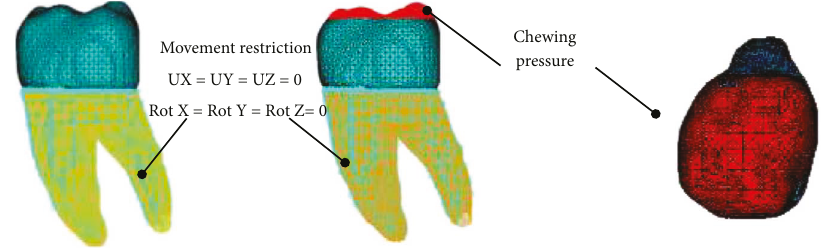
Figure 3: Boundary conditions and applied charges. Table 3: Simulation results for a load of 150 N/mm 2 .